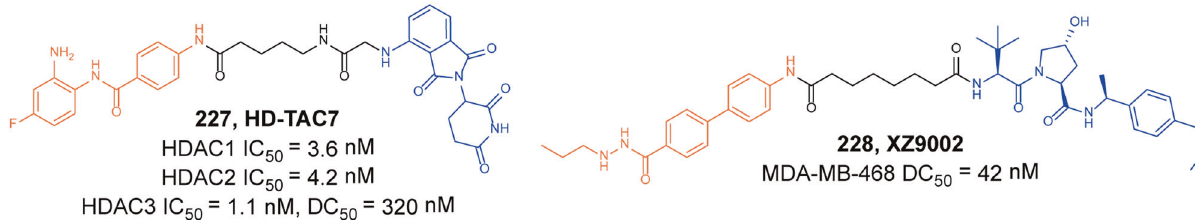
Fig. 75 The representative PROTACs targeting HDAC3